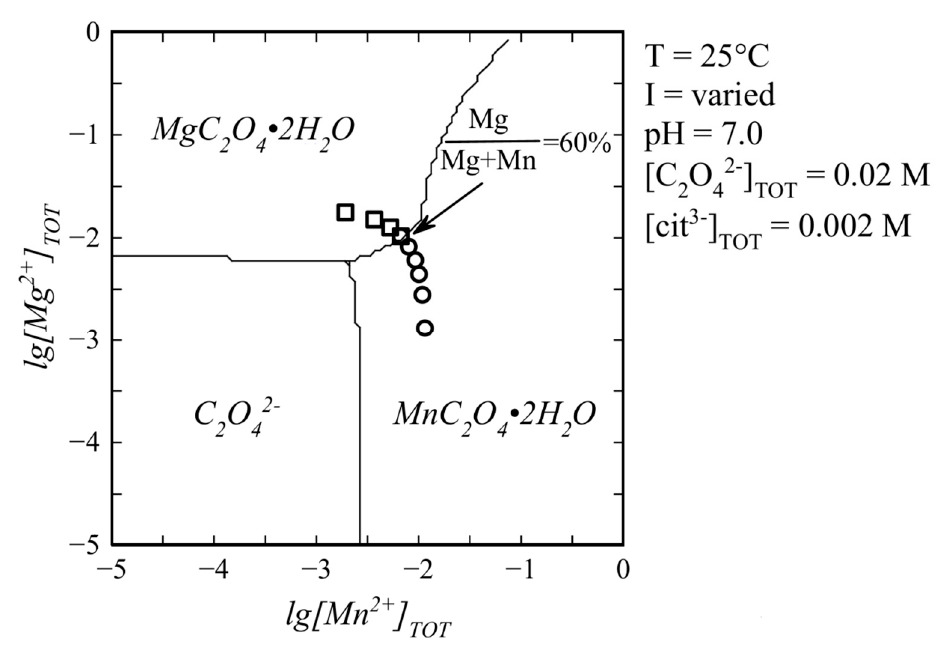
Figure 13. Typical predominance diagram for oxalate ion in water solution containing Mn 2+ , Mg 2+ and citrate ion. Markers indicate Mg 2+ and Mn 2+ concentrations in syntheses of SC series: □ —points within glushinskite field; ○ —within lindbergite field.